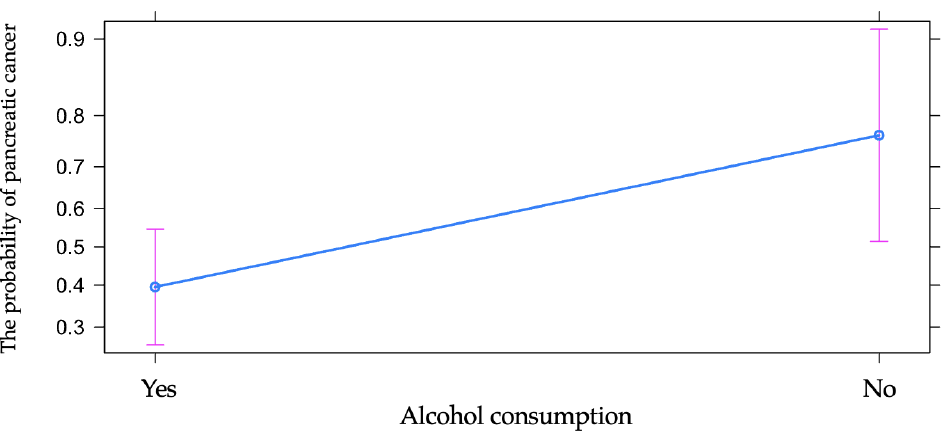
Figure 6. The influence of alcohol consumption on the risk of pancreatic cancer vs. chronic pancre-